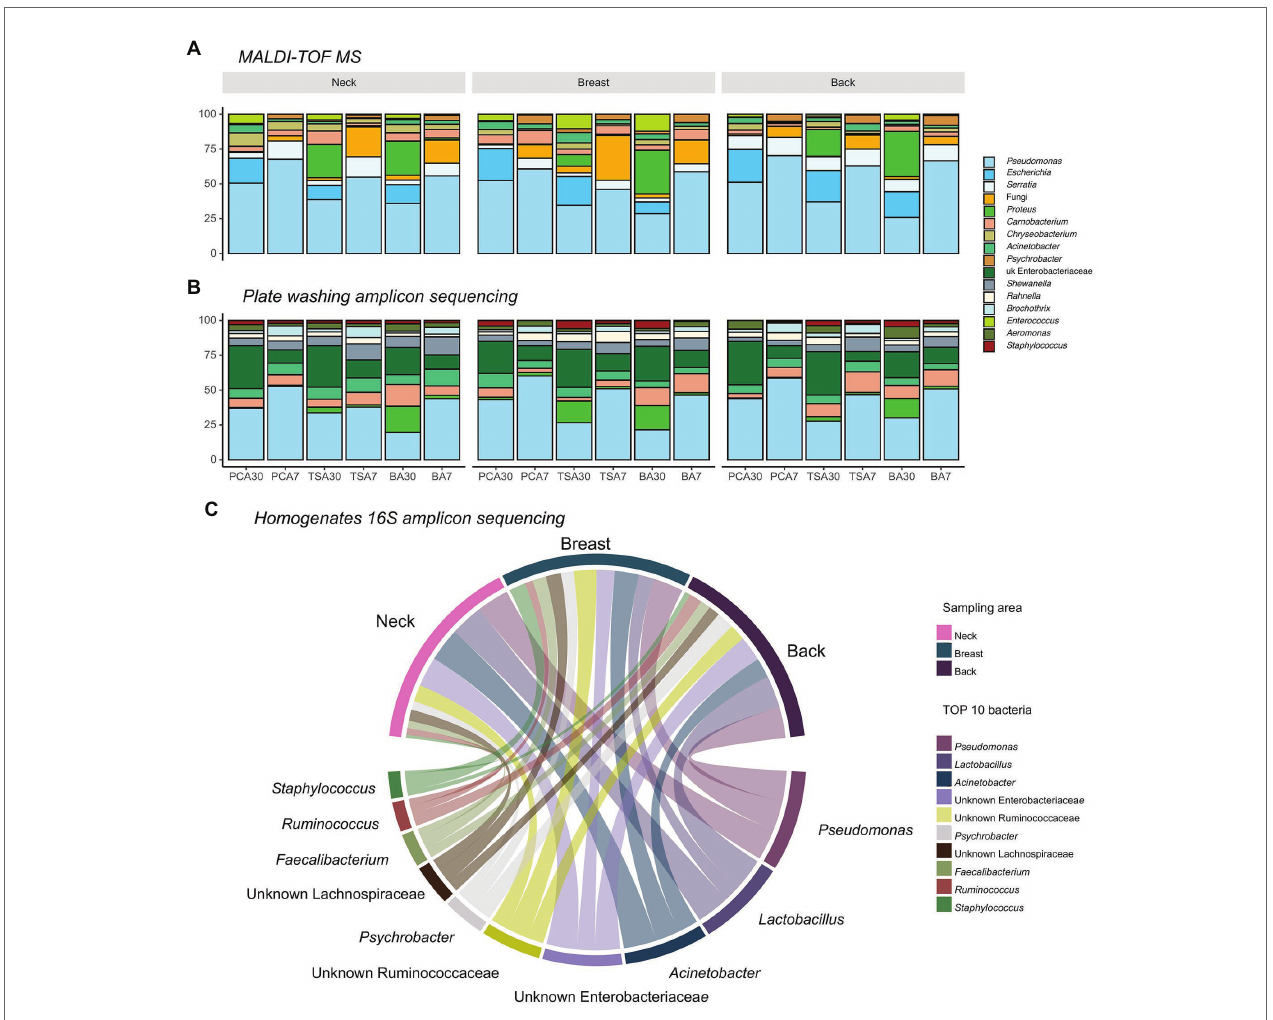
FIGURE 2 | Top 10 abundant bacteria compositions on different sampling areas using different identification methods. (A) Top 10 bacteria on isolation plates examined using matrix-assisted laser desorption ionization time-of-flight mass spectrum (MALDI-TOF MS; 82.75%); (B) Top 10 bacteria on isolation plates examined using plate washing 16S amplicon sequencing (81.38%); and (C) top 10 abundant bacteria present in homogenates examined using 16S amplicon sequencing